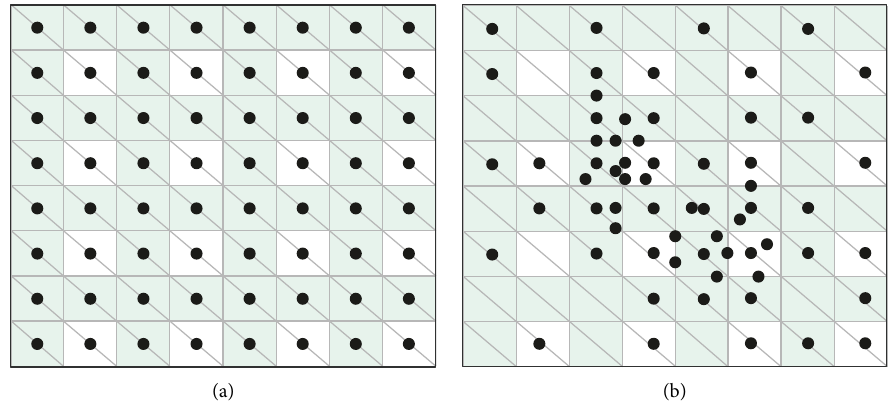
Figure 2: Clustering situation. (a) The case of uniform distribution. (b) The case where there are outliers and